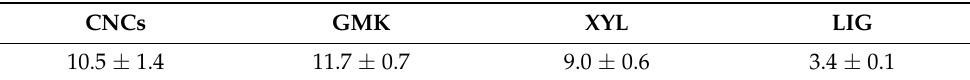
Table 2. Adhesion forces between PBS functionalized tip and lignocellulosic polymer films (nN). The abbreviations CNCs, GMK, XYL, and LIG refer to cellulose nanocrystals, glucomannan, xylan, and lignin, respectively.